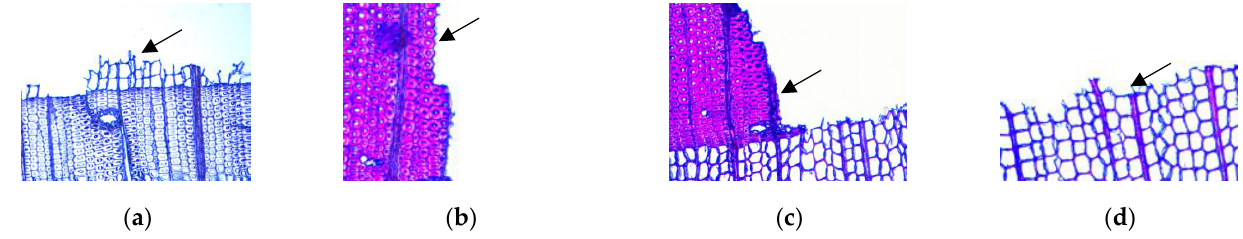
Sample 38 with narrow rings. ( b )